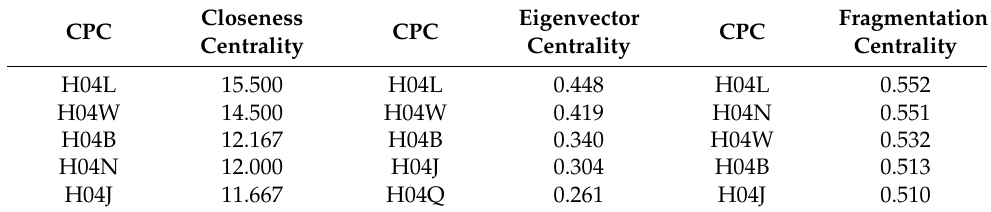
Figure 2. Cooperative Patent Classification (CPC) three-tier network diagram of laser and optical technologies. Note: The size of each node indicates the number of nodes connected to it; the thickness of the arc denotes the strength of the connection. Table 2. Top 5 CPC codes for optical networks.